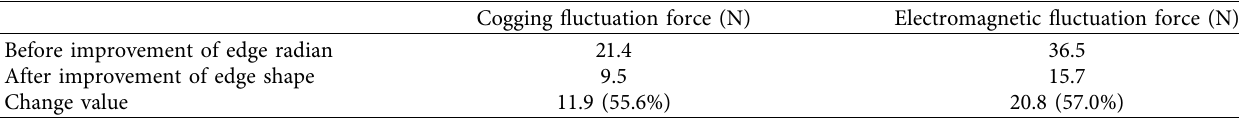
Table 3: Changes of fluctuation